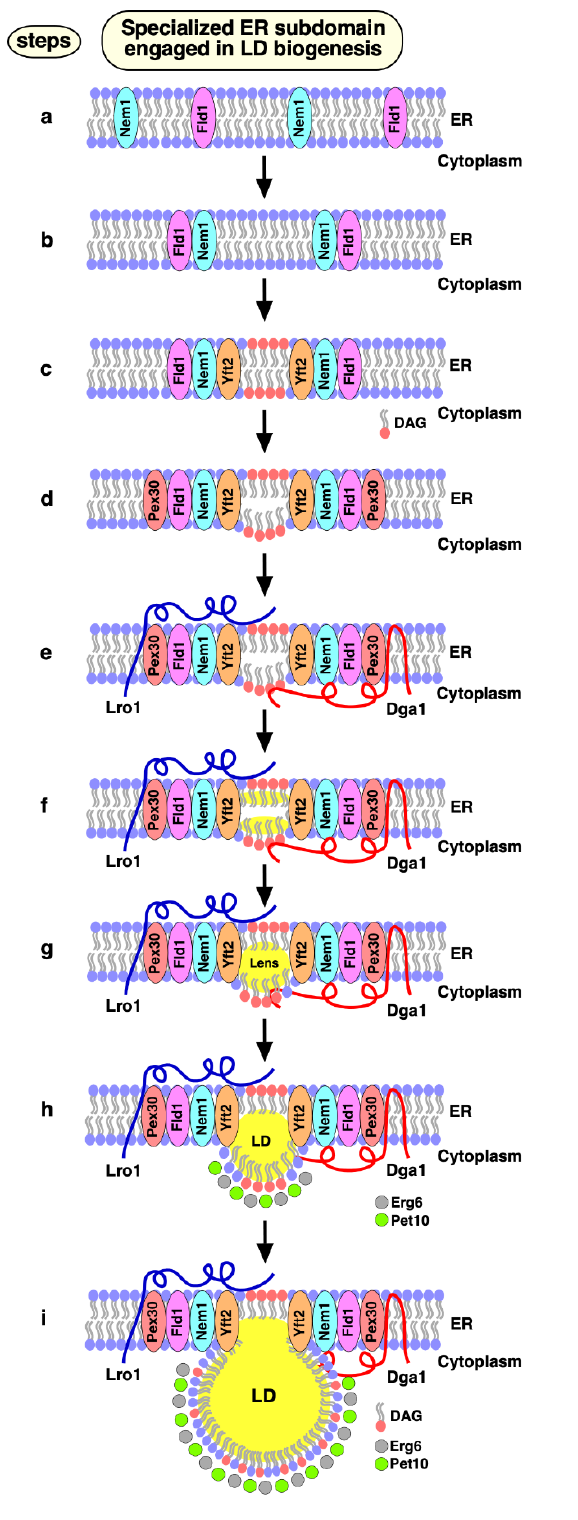
FIGURE 2: Model of LD biogenesis from specialized ER subdo- mains. a) Fld1 and Nem1 show punctate ER distribution in yeast mutants lacking LDs. b) Nem1 gets activated at sites where